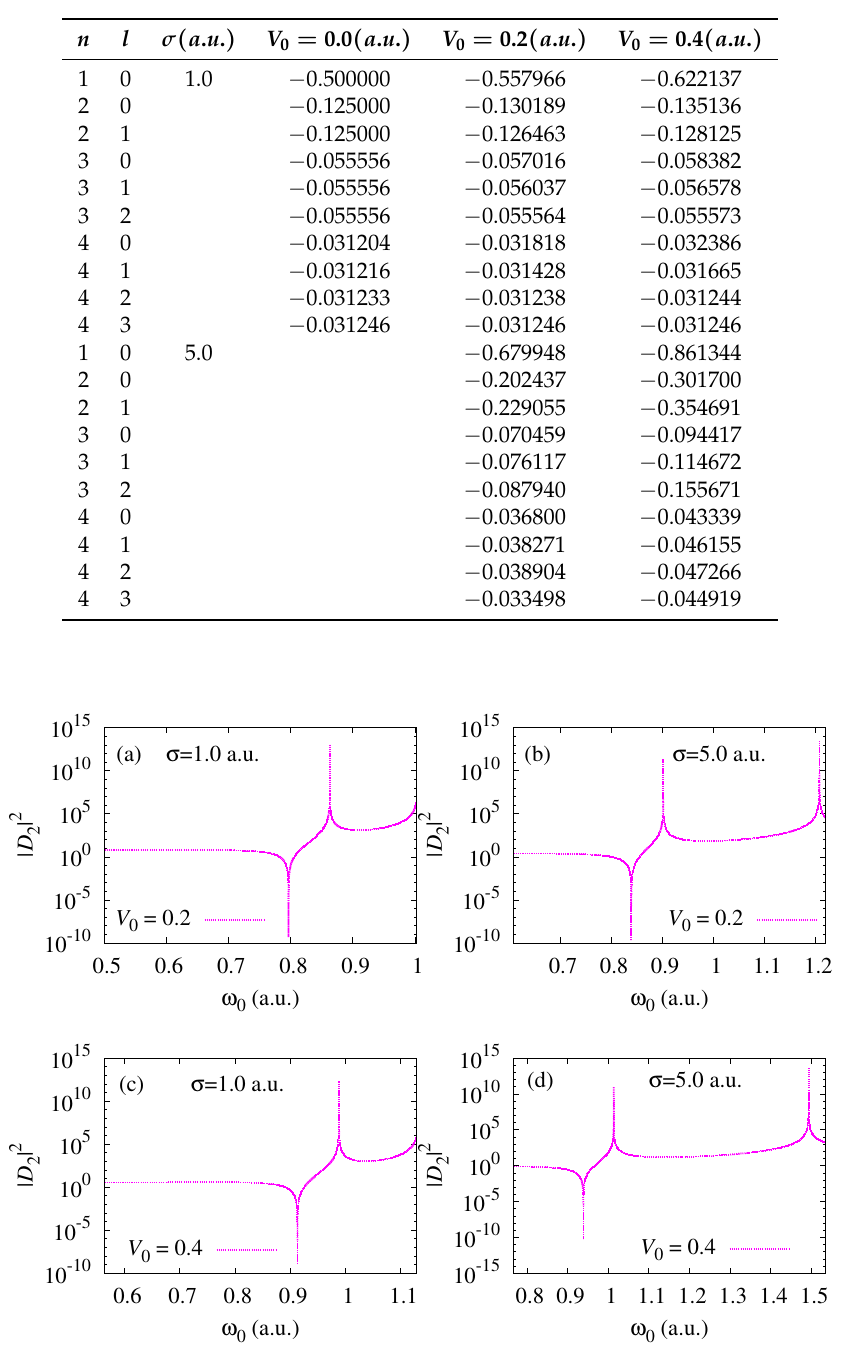
Figure 6. Variation of two-photon 1 s → 3 s absorption coefficients with frequency of incoming photons, ω 0 , for ( a ) V 0 = 0.2 a.u. and σ = 1.0 a.u.; ( b ) V 0 = 0.2 a.u. and σ = 5.0 a.u.; ( c ) V 0 = 0.4 a.u. and σ = 1.0 a.u.; ( d ) V 0 = 0.4 a.u. and σ = 5.0